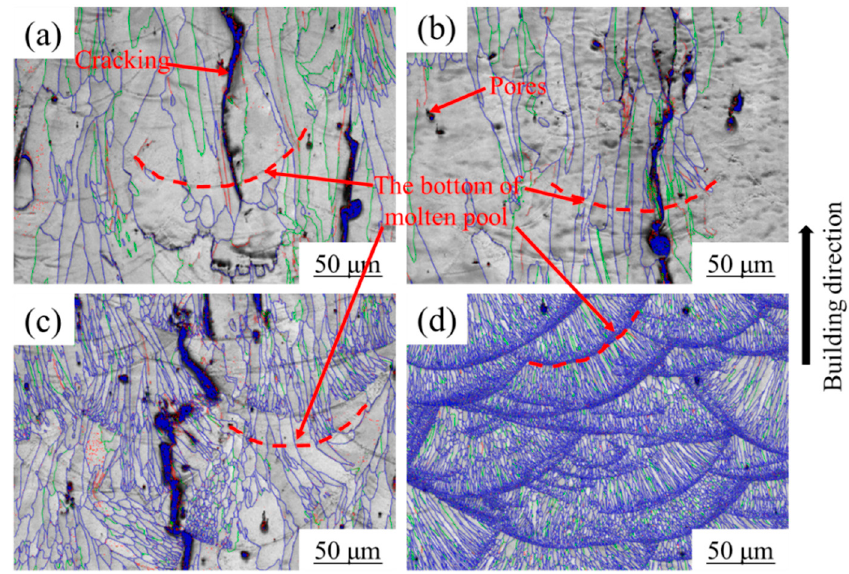
Figure 12. Grain boundary reconstruction corresponding to the Figure 11, ( a ) sample 1, ( b ) sample 2, ( c ) sample 3, ( d ) sample 4.